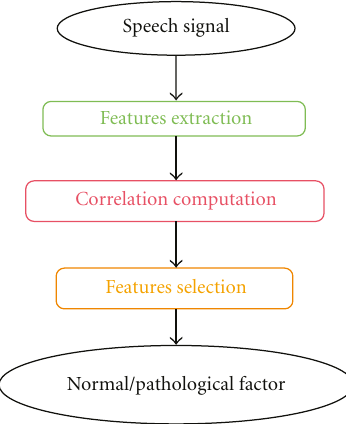
Figure 1: Structure of the analysis